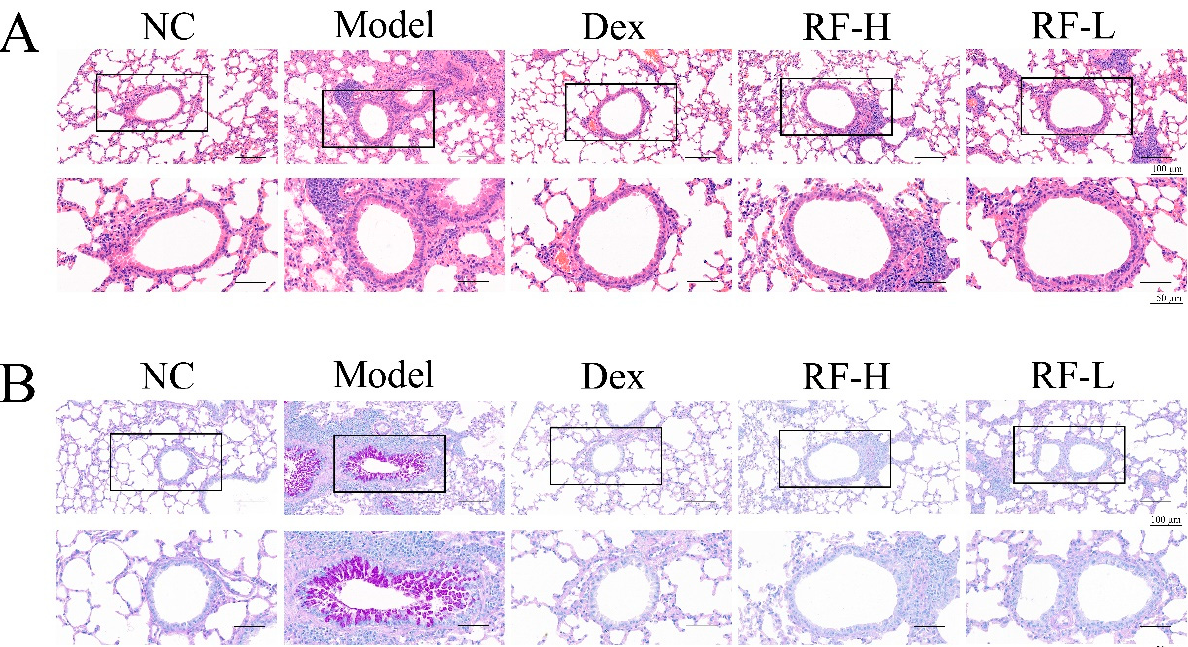
Figure 3. The effects of Renifolin F on histopathologic changes in the lung tissues of OVA-induced allergic mice in vivo. ( A ) Lung tissue sections were stained with H&E. ( B ) Lung tissue sections were stained with PAS. Normal control, saline-induced mice only. Model, OVA-induced mice. Dex, OVA-induced mice treated with Dex (1.0 mg/kg). RF-H, OVA-induced mice treated with Renifolin F (3.0 mg/kg). RF-L, OVA-induced mice treated with Renifolin F (1.5 mg/kg).